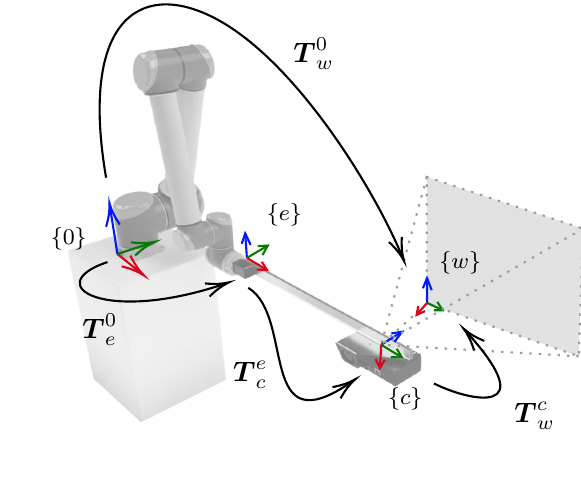
Figure 1: Coordinate transformations of a robotic 3D scanning